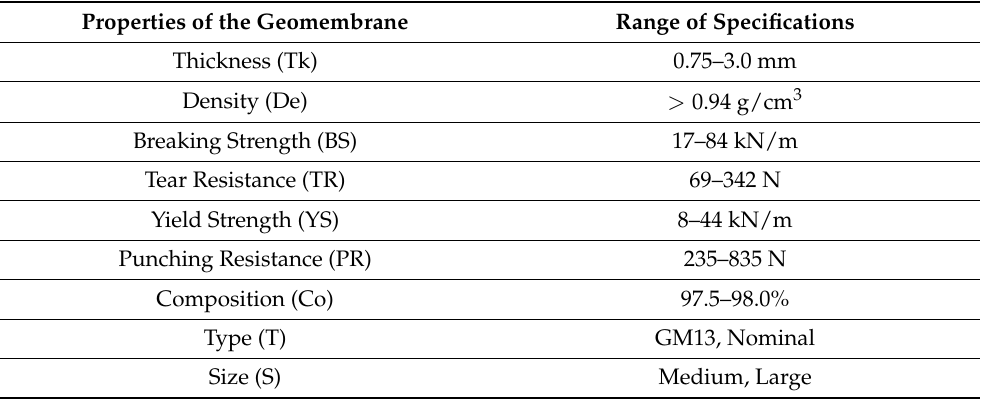
Table 1. Properties and ranges of the analyzed